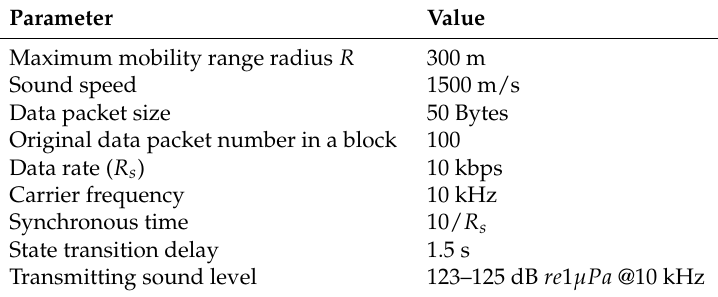
Table 2. Simulation parameters.